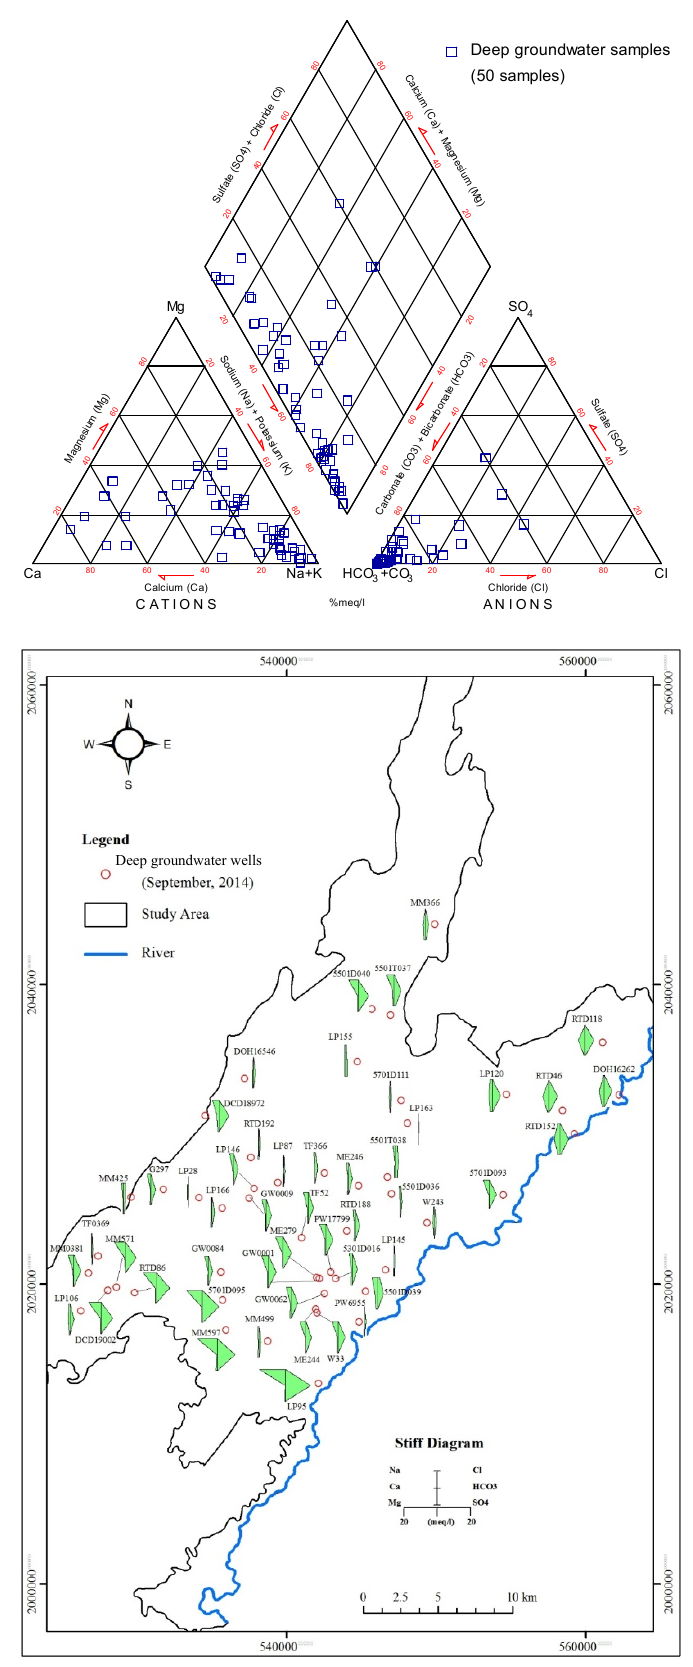
Figure 7. Piper and stiff diagrams for deep groundwater samples (wet season).